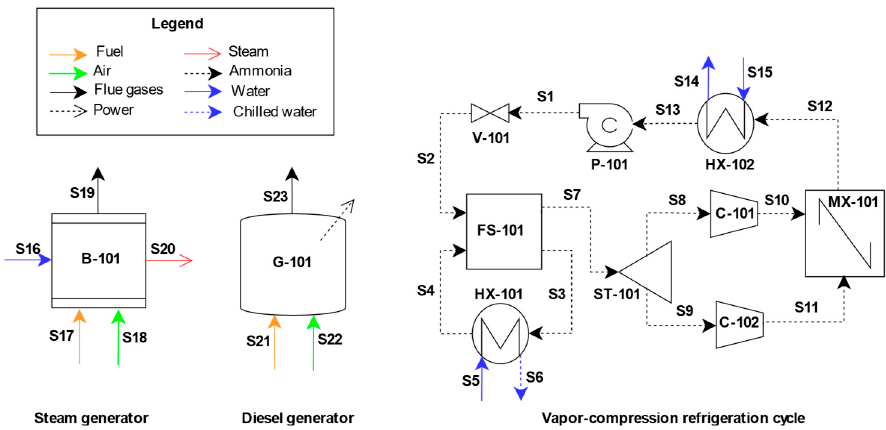
Figure 1. The non-integrated system of the instant coffee factory.